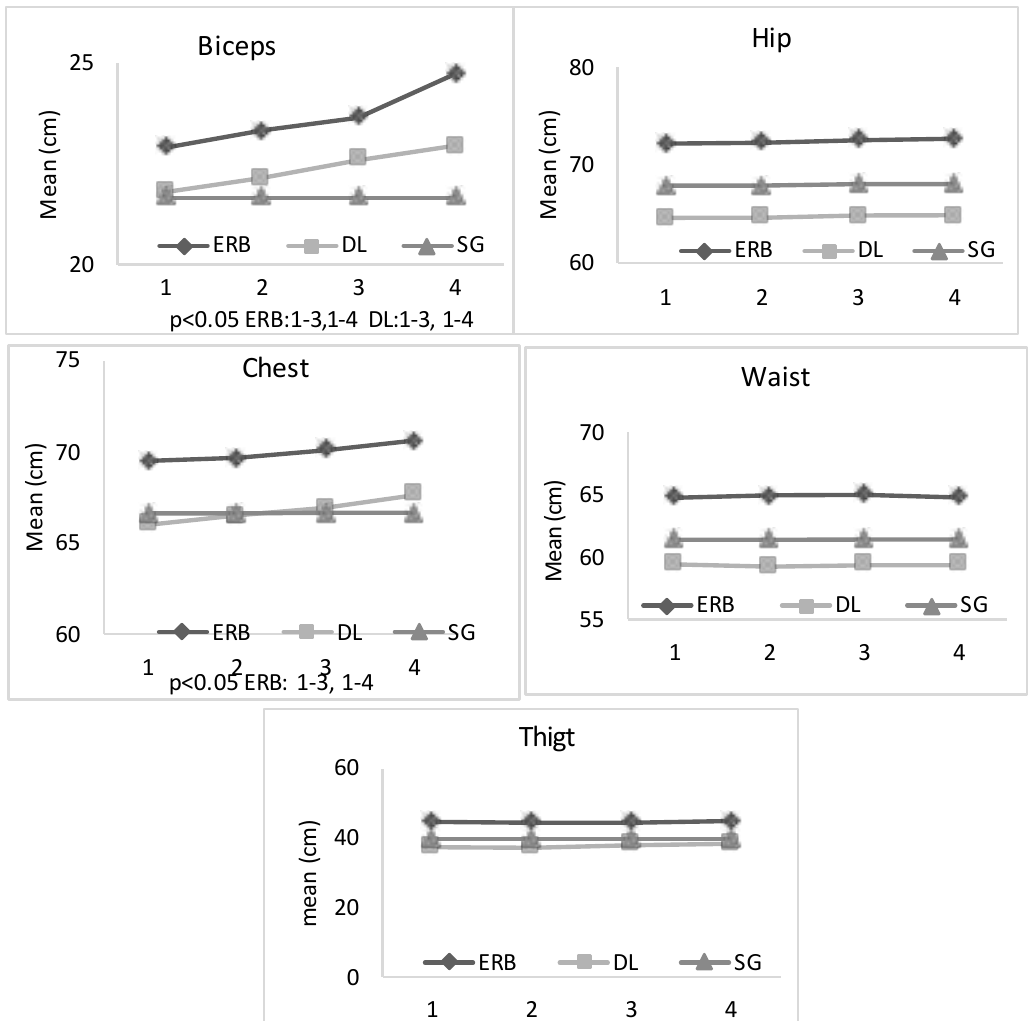
Figure 1. The circumference variables according to the